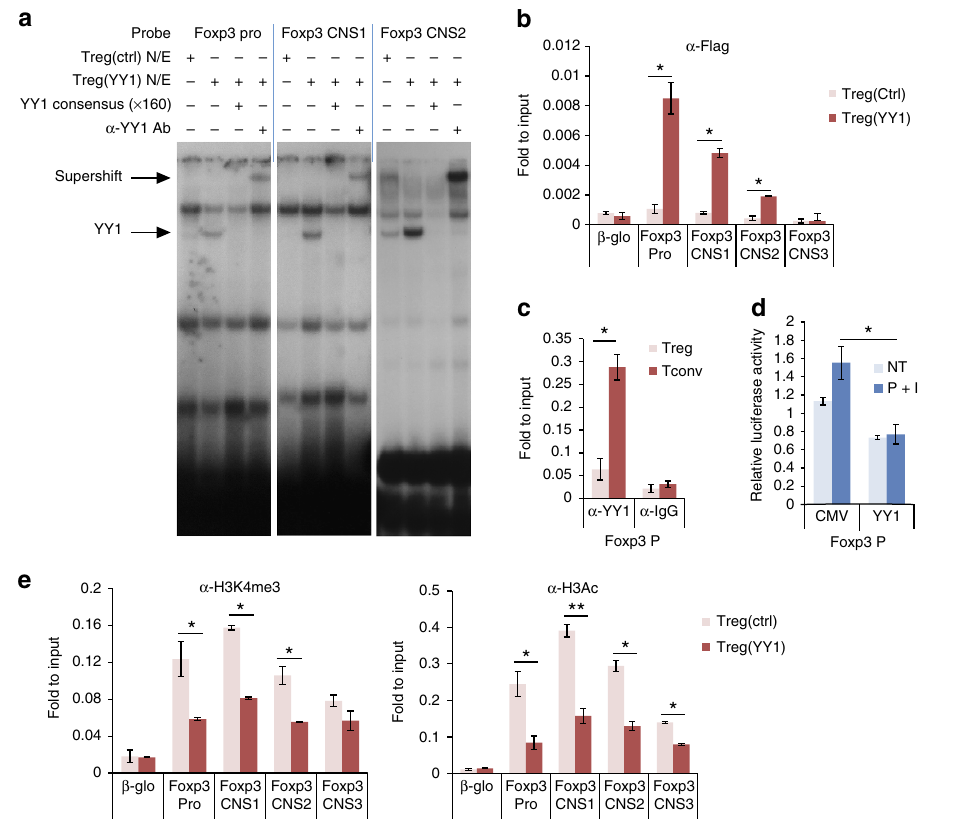
Figure 7 | YY1 represses chromatin modification in the Foxp3 locus. ( a ) Binding of YY1 to YY1-binding sites (YBS) in the Foxp3 promoter (YBS2), CNS1 (YBS4), CNS2 (YBS7) was measured by EMSA using control or YY1-expressing T reg nuclear extracts. Competition assay was performed with YY1 consensus sequence (x160), and supershift assay was performed with an anti-YY1 antibody. ( b ) Binding of YY1-Flag to the Foxp3 locus in control or YY1-Flag-expressing T reg cells was measured by ChIP assay. b -Globin region was used as a negative-binding site. ( c ) Binding of YY1 to the Foxp3 promoter in T reg or T conv cells was analysed by ChIP assay. ( d ) Transactivation activity of the Foxp3 promoter by YY1 was detected by transient reporter assay. EL4 cells were transfected with Foxp3 promoter-luc reporter construct and YY1-expression vector. I, ionomycin; NT, no treatment; P, phorbol 12-myristate 13-acetate. ( e ) Binding of H3-K4-trimethylation or H3 acetylation to the Foxp3 locus was measured by ChIP assay. b -Globin region was used as a negative-binding site. Values of isotype-matched control IgG were subtracted. Statistical significance of differences from b – e was determined by Student’s t -test ( n ¼ 3). * P o 0.05. ** P o 0.01. Data are representative of three independent experiments with similar results. Error bars shown in b – e represent